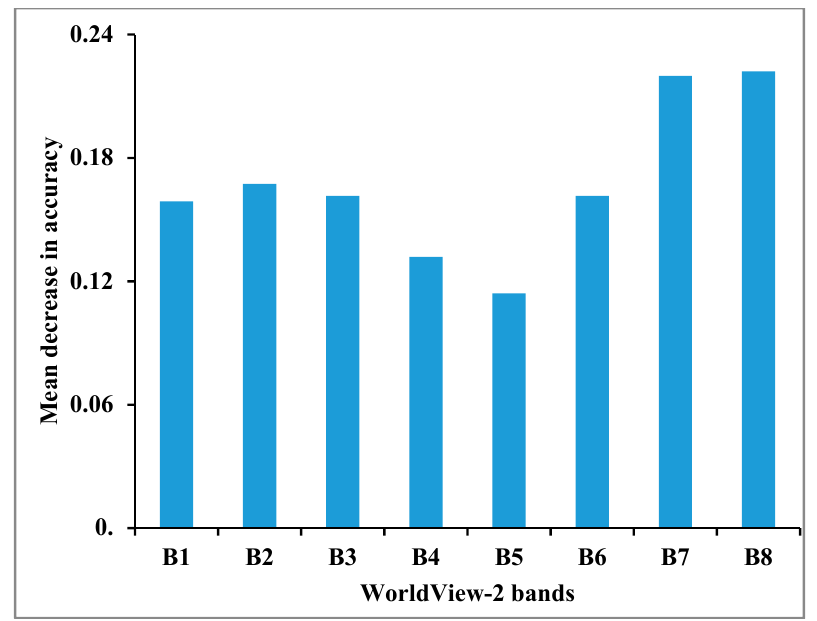
Figure 6. Illustration of the importance of WV2 bands in vegetation and other LULC classifications, calculated using the mean decrease in accuracy index. The highest mean decrease in accuracy indicates the most important bands. Bands 7 and 8 are therefore considered to be most important and Band 5 least